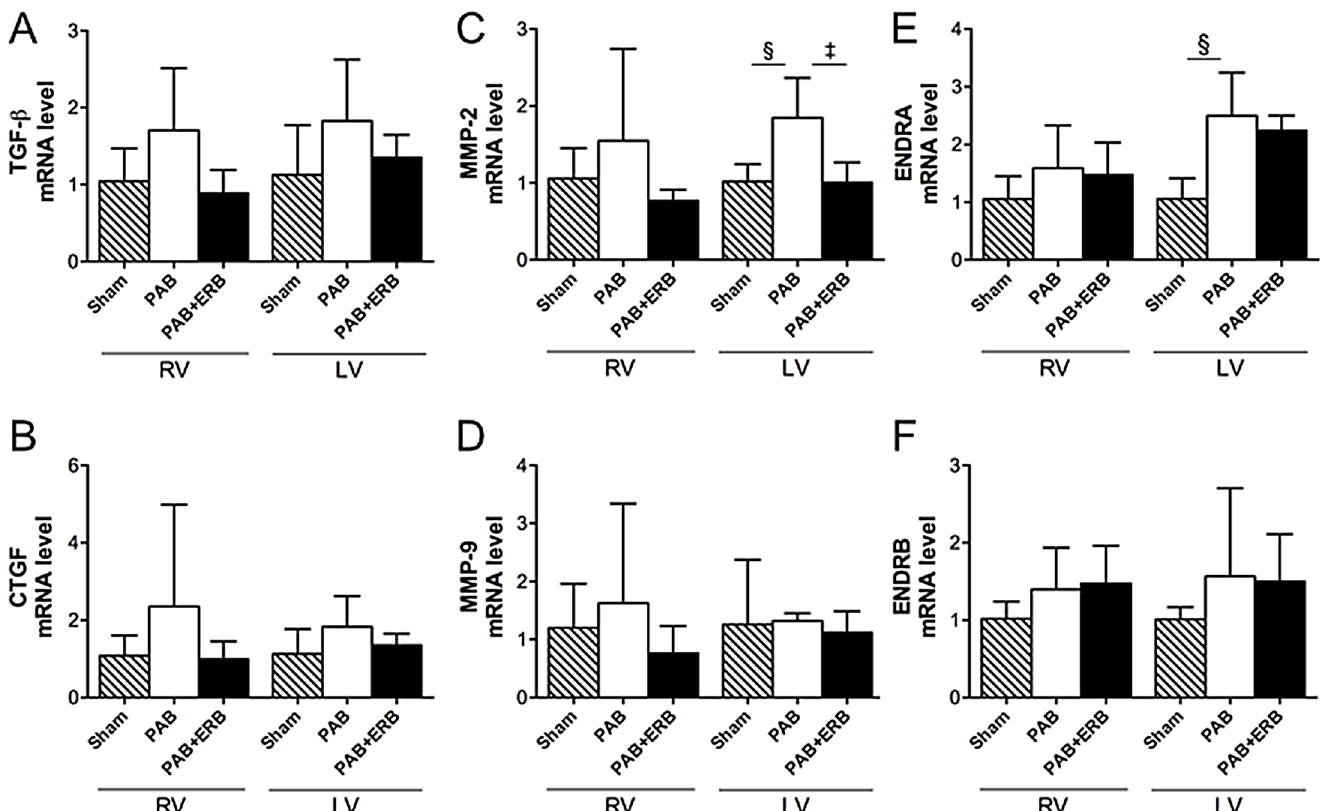
Fig 4. Real-time PCR results of mRNA expression in the myocardium. Real-time PCR data show levels of gene expression in response to endothelin receptor blocker treatment at 6-weeks after PAB. A & B) Genes related to profibrotic mediators: transforming growth factor – β 1 (TGF- β 1) and connective tissue growth factor (CTGF). C & D) Matrix metalloproteinase (MMP) -2 and MMP-9 gene expression. In the LV MMP-2 showed significant up-regulation in response to pulmonary arterial banding (sham vs. PAB §p (cid:1) 0.05) and decrease with addition of macitentan ‡ p (cid:1) 0.05). E & F) Endothelin receptor type A (ENDRA) and endothelin receptor type B (ENDRB); ENDRA was significantly up-regulated in the LV as a response to PAB, §p (cid:1) 0.01. G & H) α - and β -MHC: myocyte heavy chain. Sham (n = 4), PAB-group (n = 5), and PAB+ERB (n = 5). RV: right ventricle, LV: left ventricle, PAB: pulmonary artery banding, and ERB: endothelin receptor blocker.